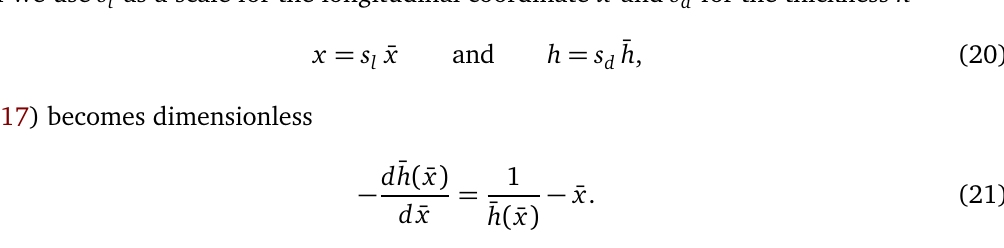
Figure 3: The scaled thickness ¯ h of the layer as a function of the scaled position ¯ x in the melting regime. The curves are evaluated for some values of the scaled contact length ¯ l . For negative ¯ x the water layer is irrelevant. It may be given the constant value ¯ h ( ¯ x ) = ¯ h ( 0 ) . = 2.16 mm For the skating velocity V = 8m / s, we have as the scale for the contact length s l = 0.21 µ m. Both are rather small. and as scale for the thickness s d